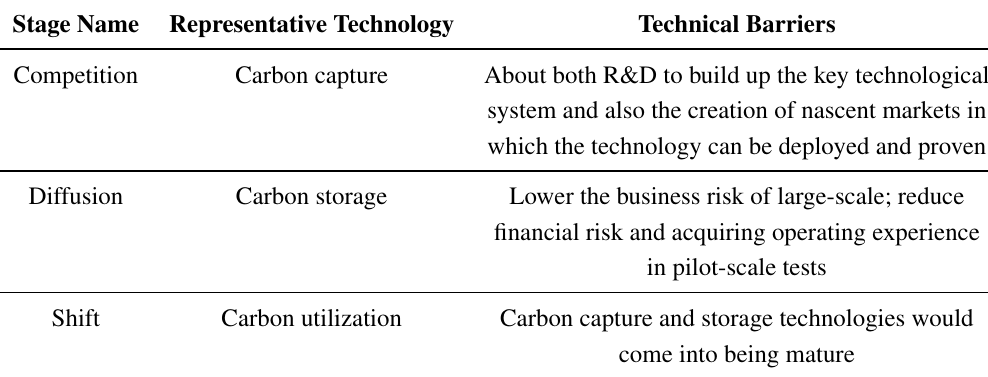
Table 1. The carbon capture and storage techno-paradigm (CCSTP)